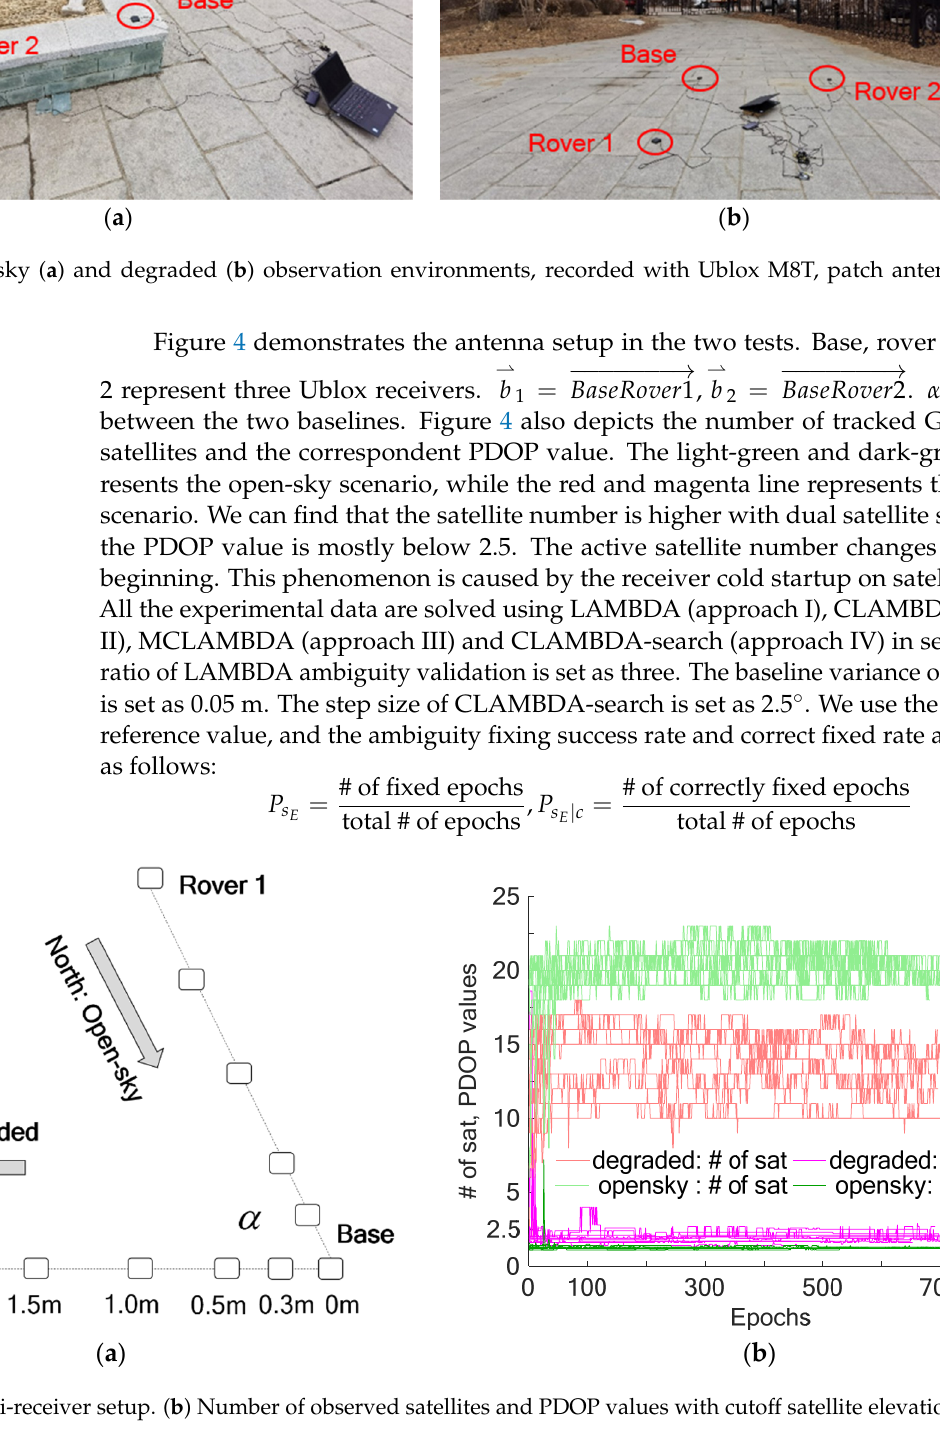
Table 1. SFSE (single-frequency single epoch) ambiguity fixing rate and correct fixed rate of various designed and actual baseline lengths (GPS-only observations, open sky), LAMBDA (approach I), CLAMBDA (approach II), MCLAMBDA (approach III) and CLAMBDA-search (approach IV). The column in the table is the designed baseline length. Method